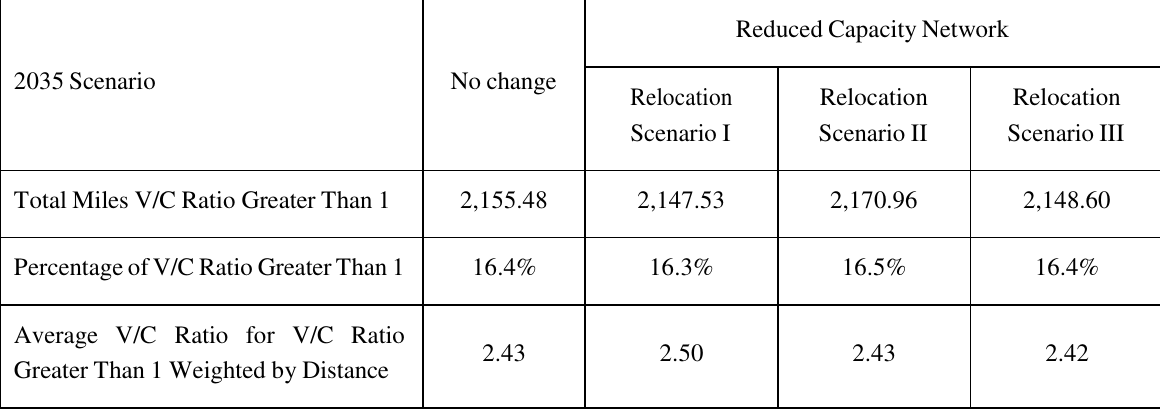
Table 4 Summary of the model results for the total volume-to-capacity ratio